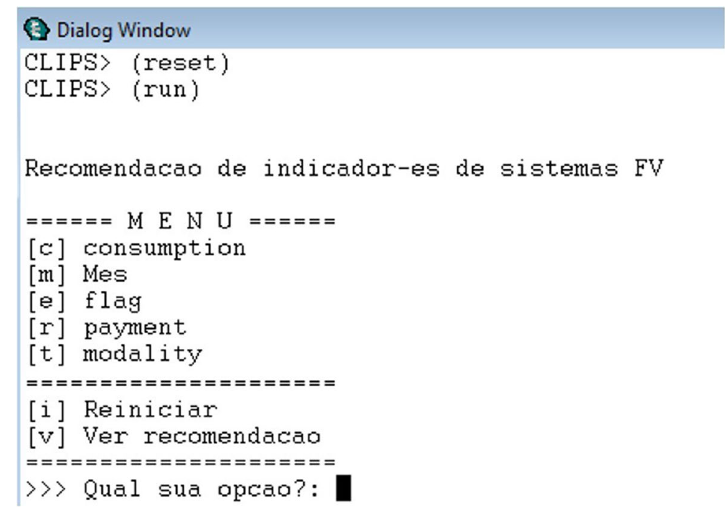
Fig. 11 Dialog window created in